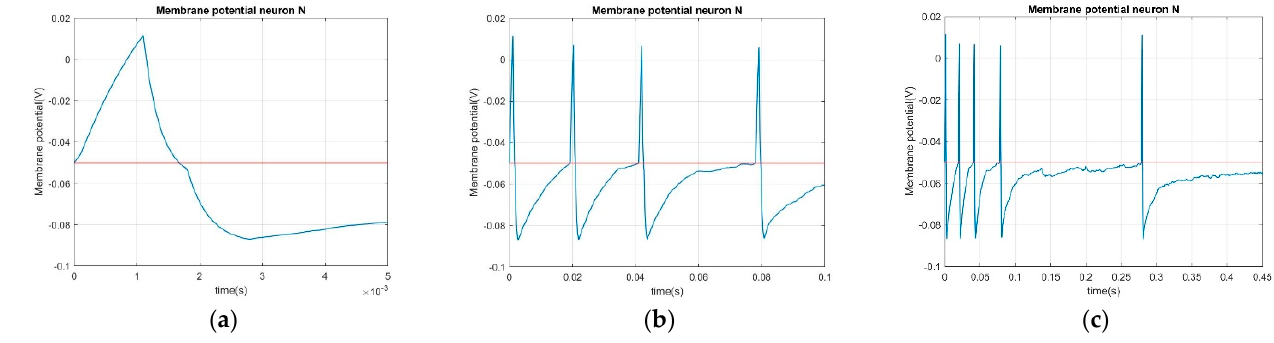
Figure 1. Membrane potential of neuron N—individual neuron dynamics ( a – c ).